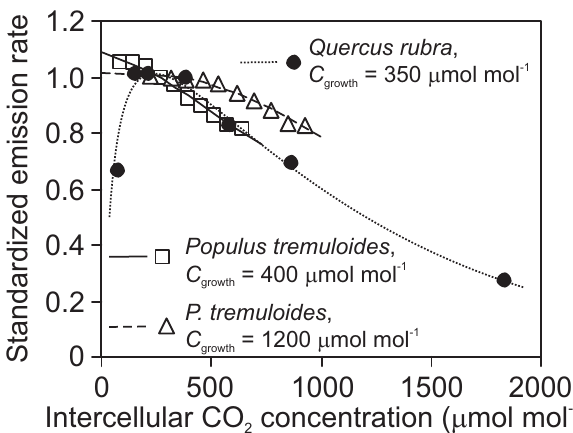
Fig. 3. Isoprene emission rate in relation to intercellular CO 2 con- centration ( C i ) in Quercus rubra plants grown at an ambient CO 2 concentration of 350µmolmol − 1 (data from Loreto and Sharkey, 1990) and in Populus tremuloides plants grown at ambient CO 2 concentrations of 400 and 1200µmolmol − 1 (data from Wilkinson et al., 2009). Data for P. tremuloides were fitted by Eq. (7), while an empirical non-linear relationship with a maximum was used to fit the data for Q. rubra